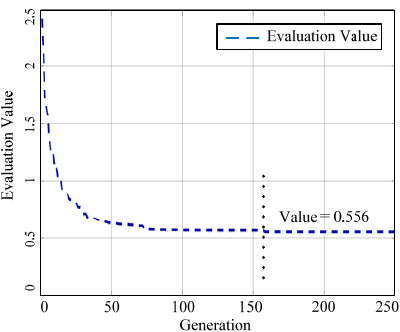
Figure 4. The minimum objective value in each generation.